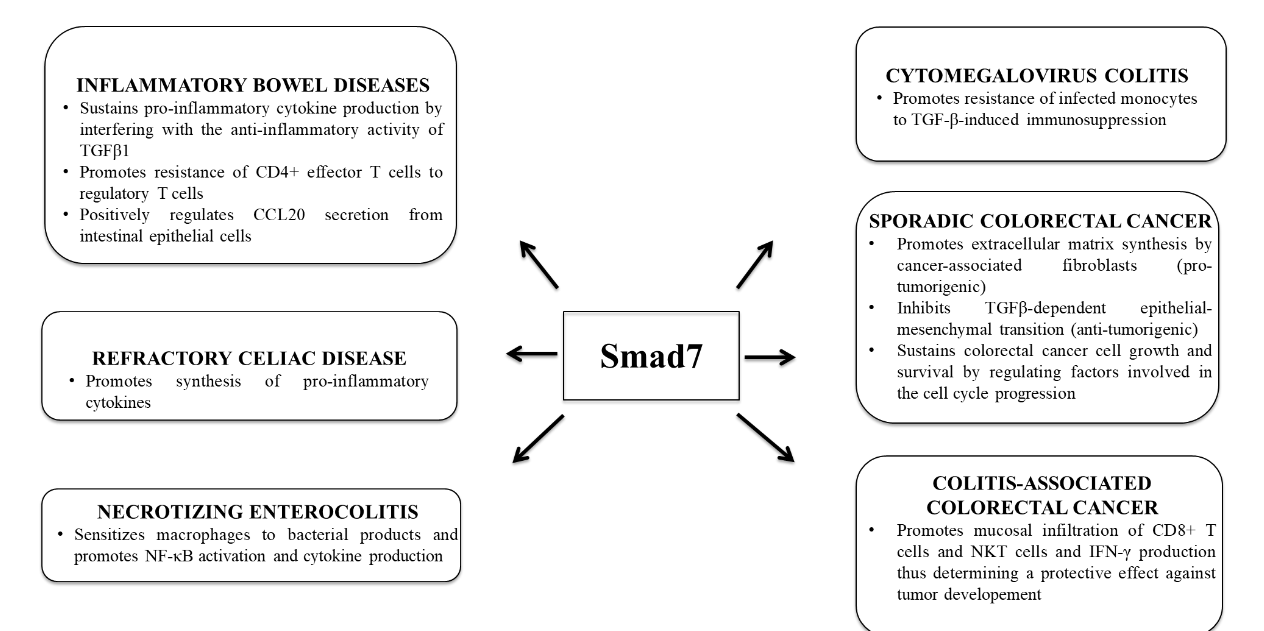
Figure 2. Function of Smad7 in intestinal inflammatory diseases and colon cancer.